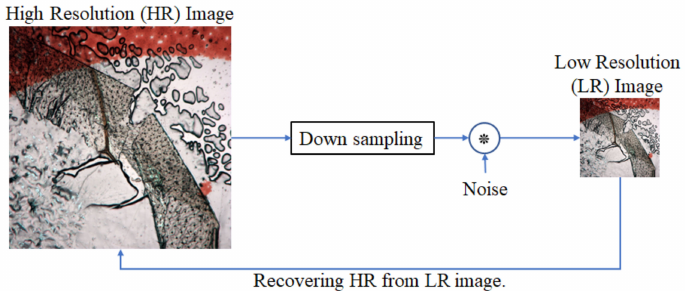
Figure 2. The basic concept of the single image super-resolution (SISR) algorithm. High-resolution images are downsampled to the corresponding low-resolution image and that low-resolution image inversely reconstructs the high-resolution image. The model is learned from the noise term during the training